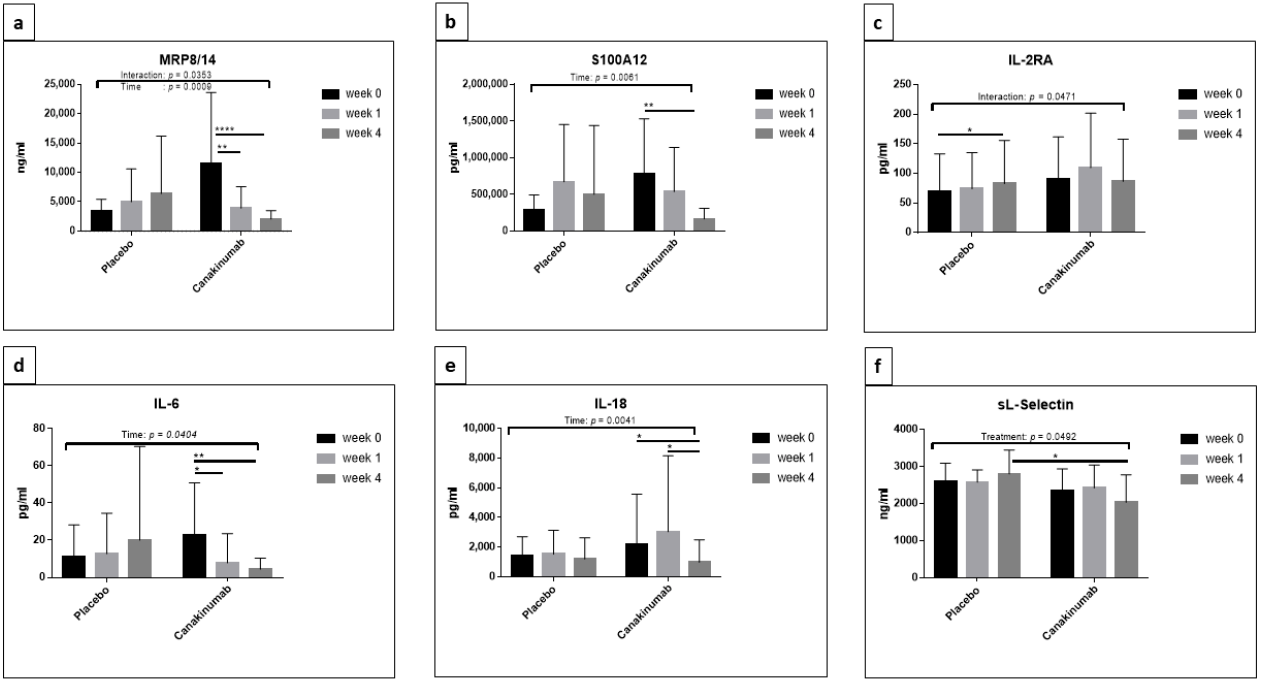
Figure 1. Representative cytokines that showed a significant reduction under the effect of canakinumab. A comparison of the concentrations of MRP8/14 ( a ), S100A12 ( b ), IL-2RA ( c ), IL-6 ( d ), IL-18 ( e ) and sL-Selectin ( f ) between placebo and canakinumab patients at week 0, week 1 and week 4 was applied. The bar plots represent the mean with SD. Two-way repeated-measures ANOVA with Tukey’s multiple comparisons test and Sidak’s multiple comparisons test was performed using GraphPad Prism 7 and statistical significance was set at p < 0.05. * p < 0.05, ** p < 0.01 and **** p < 0.0001.